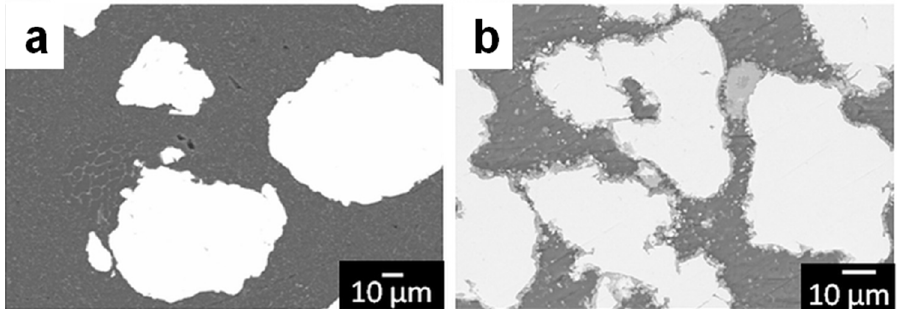
Figure 13. Microstructure of composites obtained from Al 2024 + 40 vol.% Ni 60 Nb 40 mixtures: ( a ) as-hot-pressed state and ( b ) heat-treated state. Reprinted from [71], Copyright (2019), with permission from Elsevier.